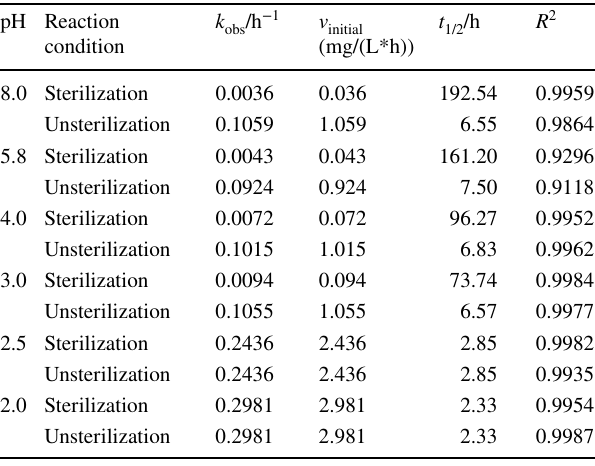
Table 2 Rate constants and half-time of Cr(VI) reduction at different pH values pH Reaction condition